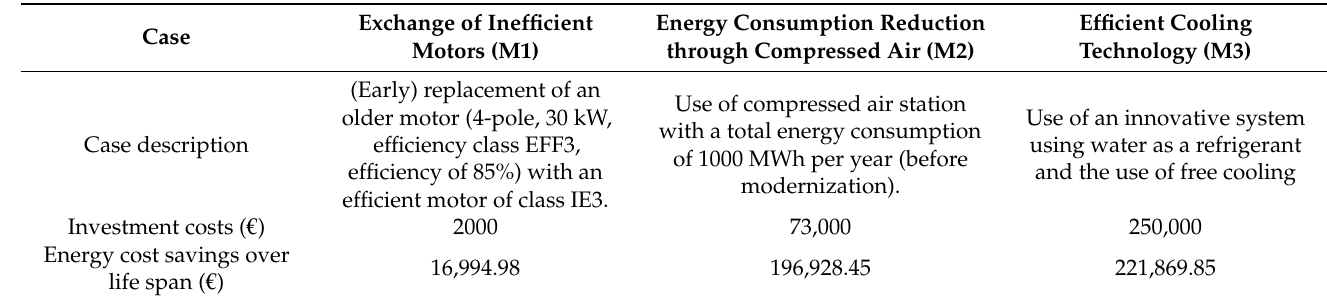
Table 1. Cases developed in the businesses sector to perform an enhanced cost–benefit analysis (Sources: M1: [35], M2: [44], and M3: